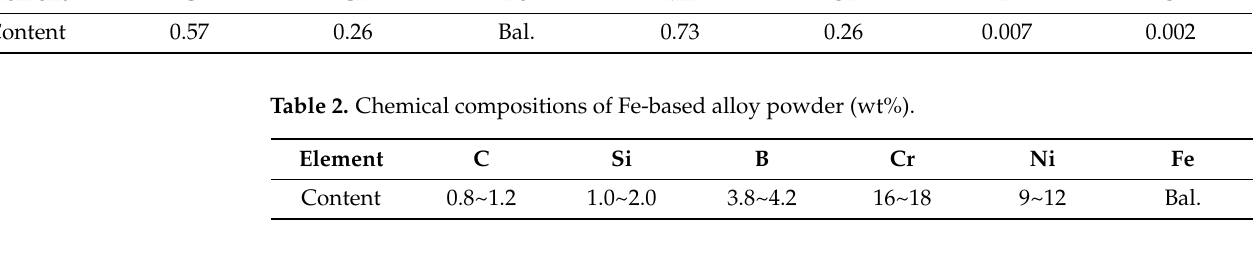
Table 3. Chemical compositions of Ni-based alloy powder